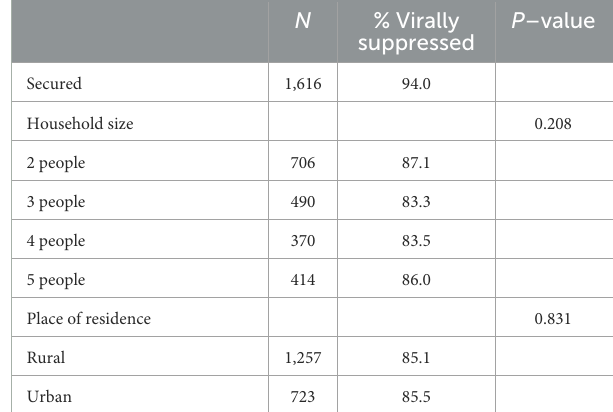
TABLE 2 OVCLHIV viral suppression rate by interventions and other background characteristics ( N =